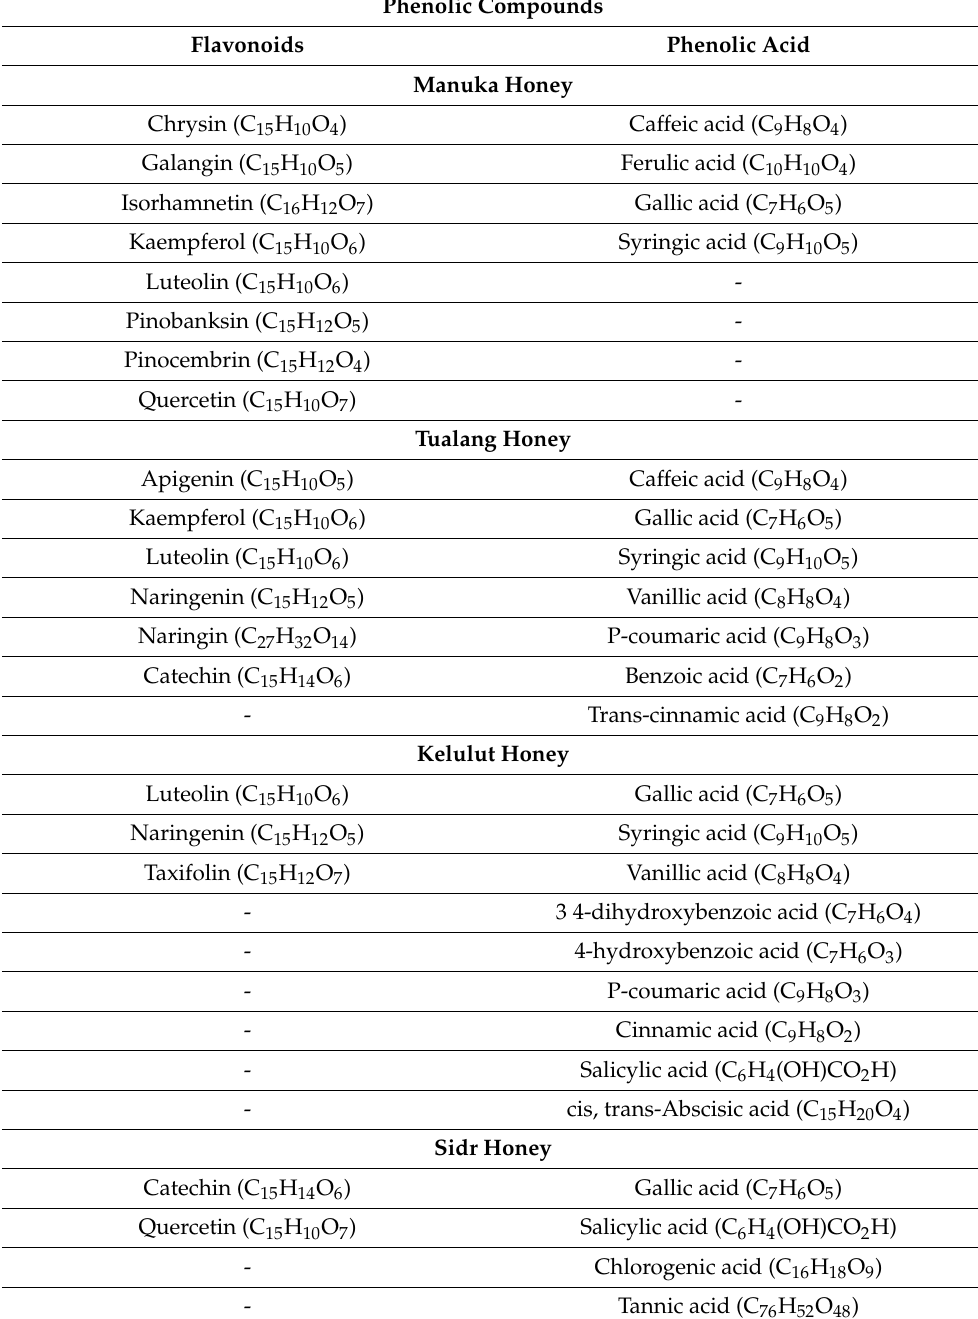
Table 2. The most common phenolic compounds (flavonoids and phenolic acids) identified in MH, TH, KH, and SH